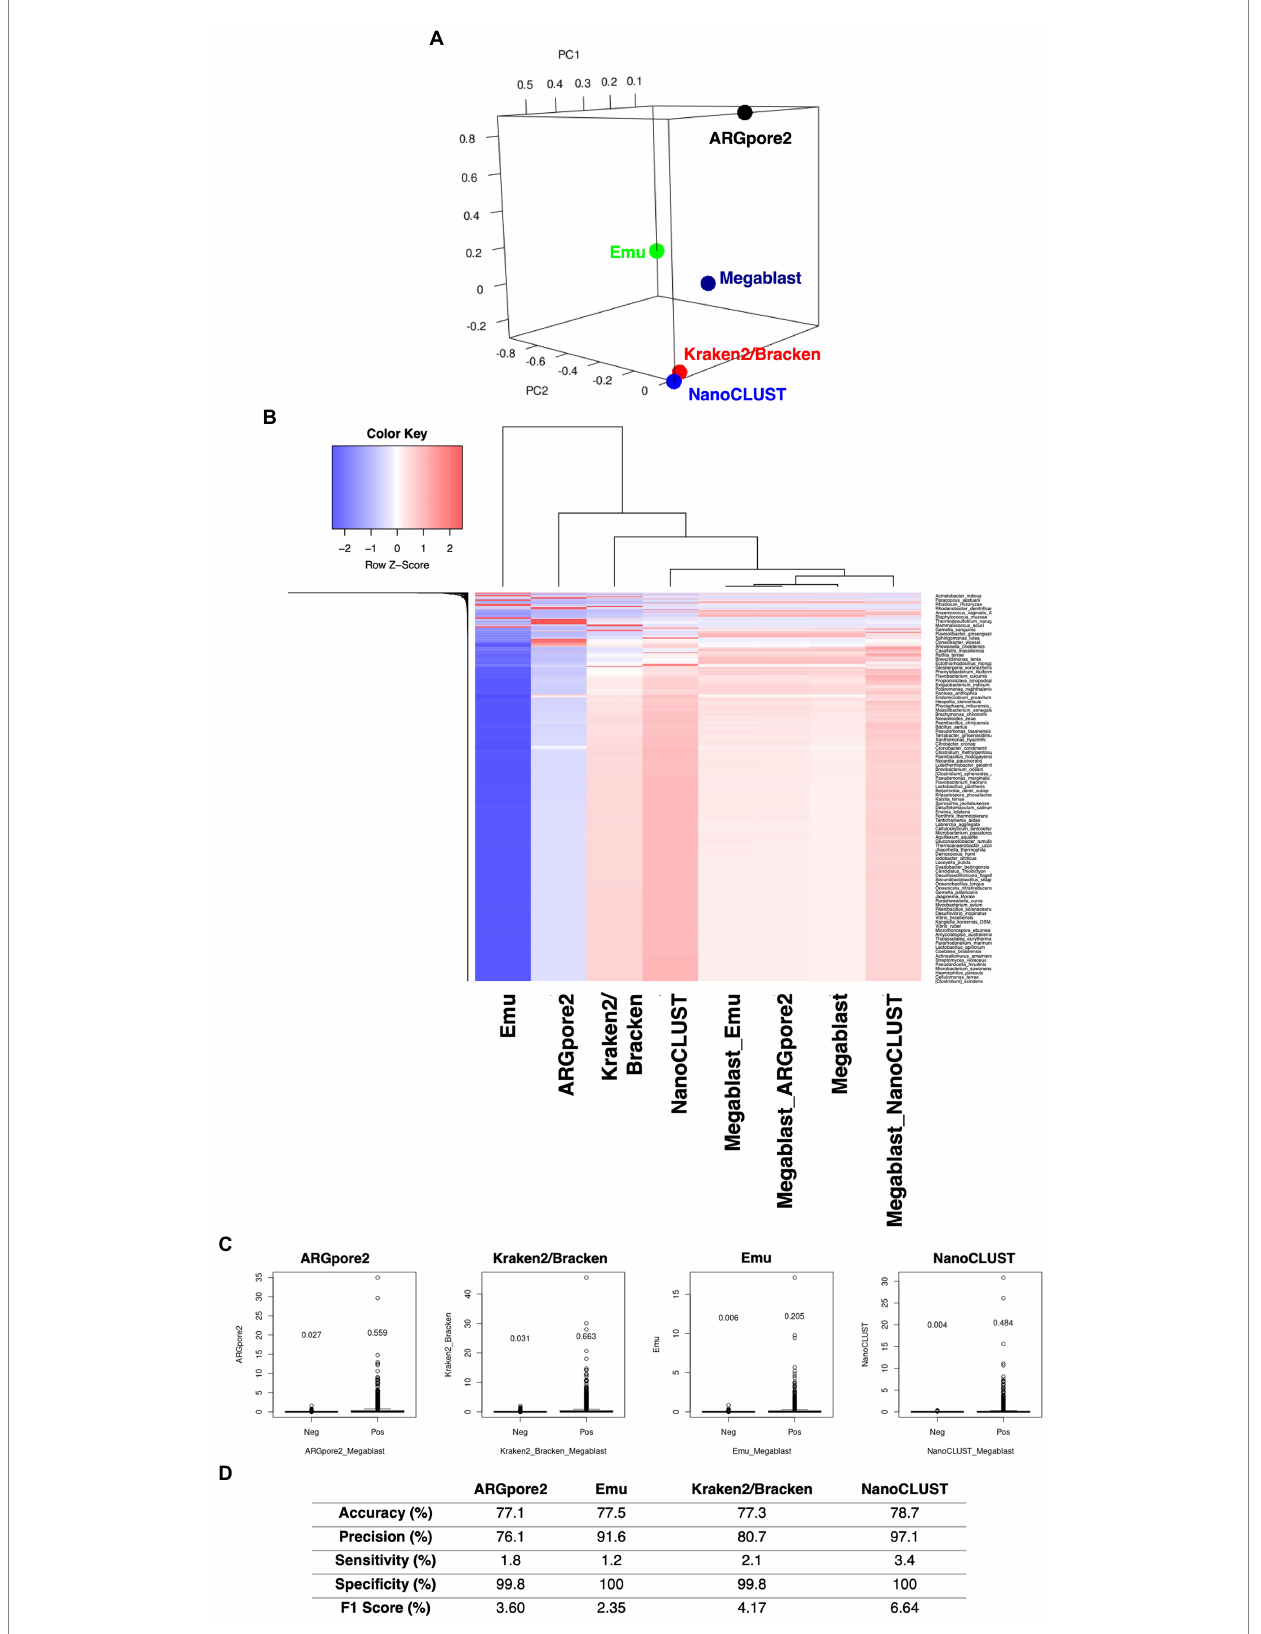
FIGURE 2 Comparisons of the microbiomes classified by MegaBLAST and the four classifiers. (A) Principal component analysis of microbiomes classified by MegaBLAST and the four classifiers, 20 urban examples that appeared in all of the classifiers were chosen. (B) Hierarchical clustering of the